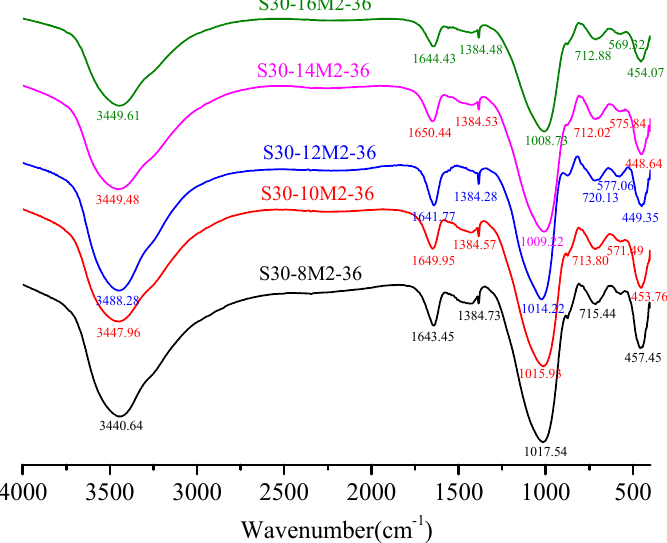
Figure 8. FTIR characterization of hardened paste with different NaOH molar concentration.